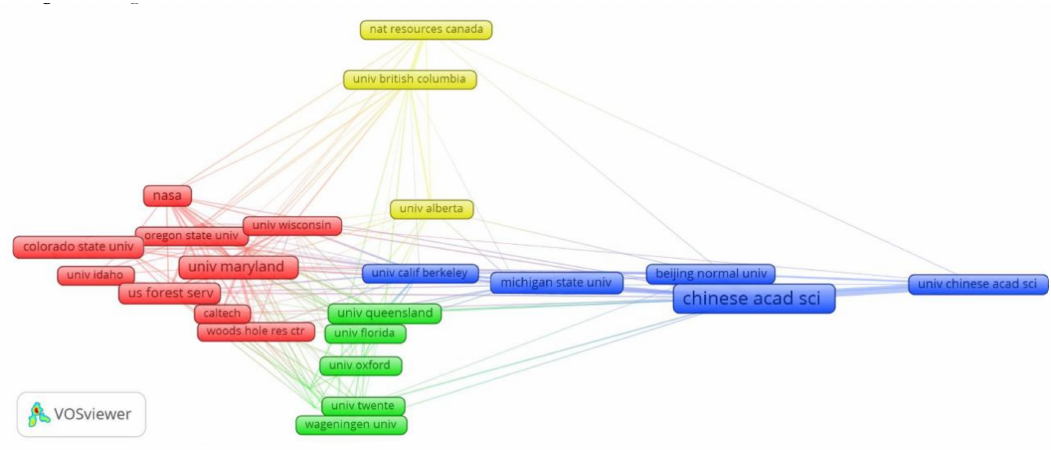
Figure 5. Co-authorship cooperation between productive institutions. The colors represent clusters of institutions, the size of frames represents the number of articles published by these institutions, and the lines represent the strength of cooperation among